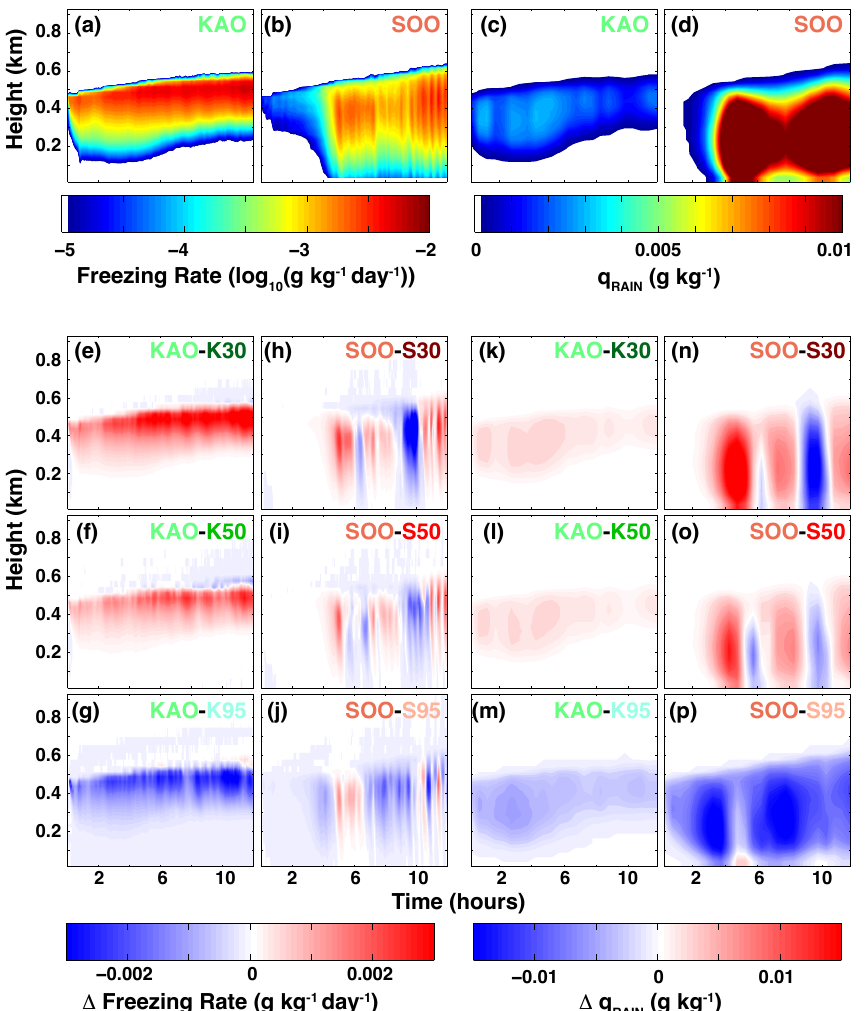
Fig. 11. Domain-averaged time-height cross-sections of immersion freezing rates for the KAO (a) and SOO (b) simulations, as well as differences between domain-averaged freezing rates in those simulations and simulations assuming different soluble mass fractions (e–j) . Also plotted are domain-averaged time-height cross-sections of rain water mixing ratio for the KAO (c) and SOO (d) simulations, along with differences between domain-averaged rain water mixing ratios in those simulations and simulations assuming different soluble mass fractions (k–p)